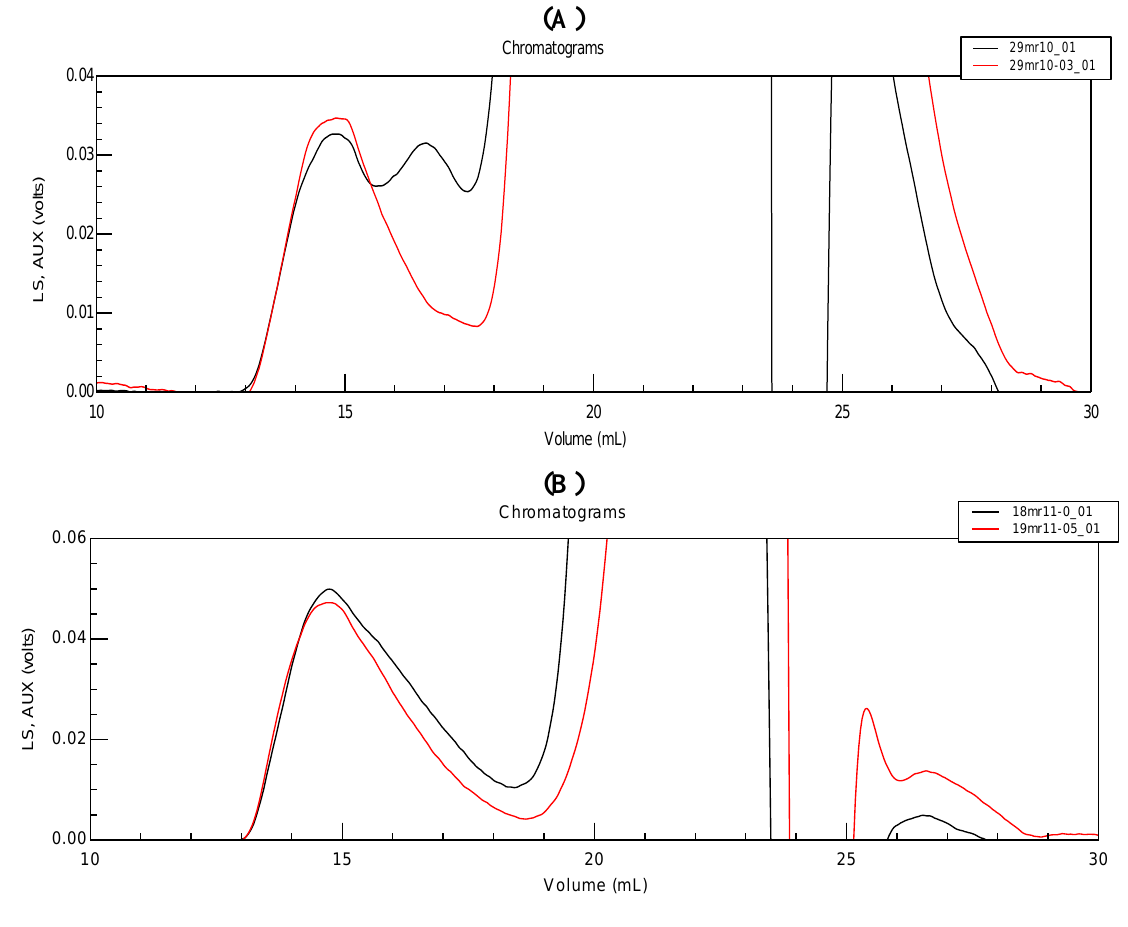
Figure 9. Chromatograms of two different synovial fluids (A and B) before (black) and after protease treatment (red).The traces are those for the polymer concentration; enlargement of the HA signal is shown at a elution volume of around 15